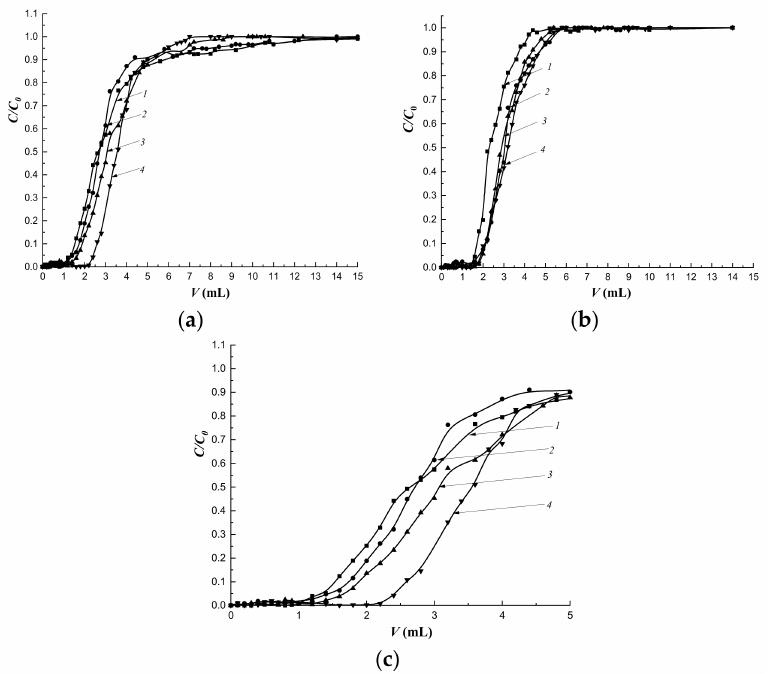
Figure 11. Dynamics of cholesterol sorption at different flow rates: ( a ) 0.25 mL · min − 1 ; ( b ) 0.5 mL · min − 1 ; ( c ) initial section at a rate of 0.25 mL · min − 1 . Column height—3.0 cm, C 0 = 16 mmol/L; 1 —CP-1; 2 —MIP-1-2; 3 —MIP-1-4; 4 —MIP-1-6.